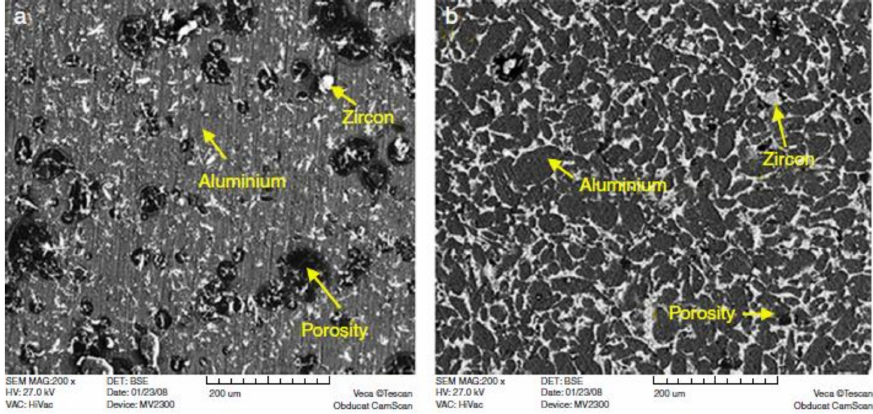
Figure 7. SEM images of the composites (sintered at 600 ◦ C) ( a ) having 5 vol% zircon particles and ( b ) 15 vol% zircon particles